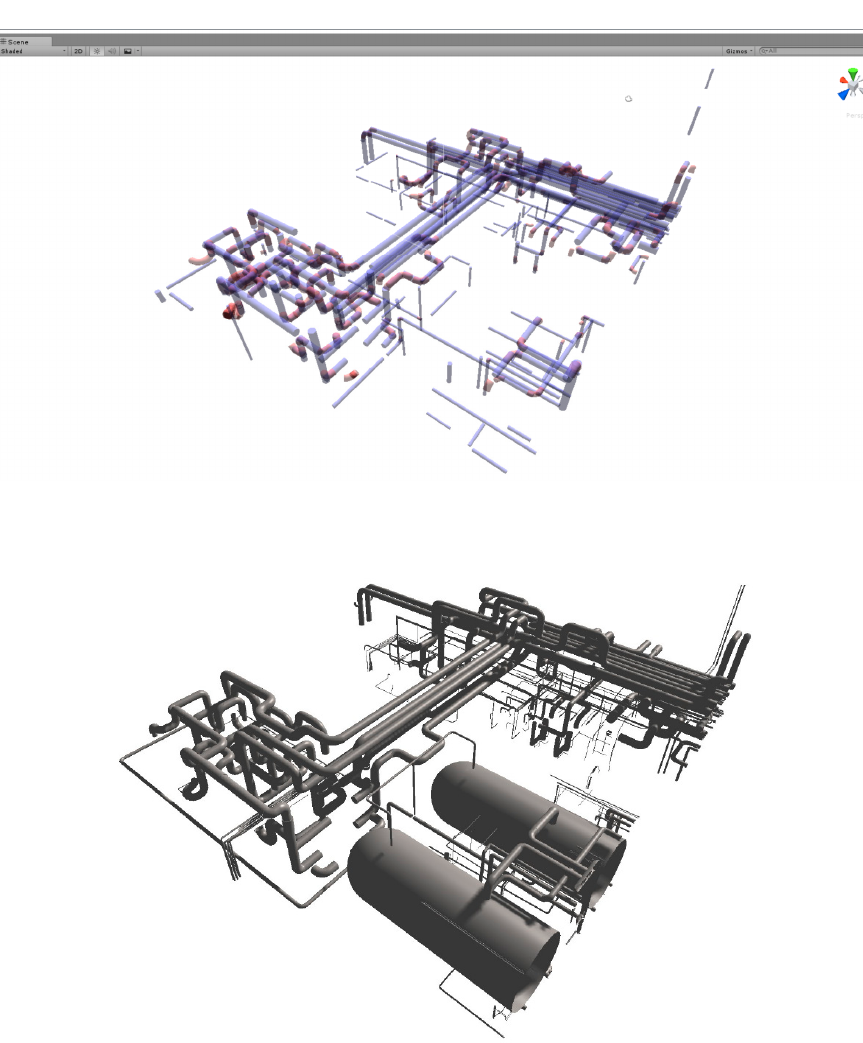
Figure A1. This figure is the result of modeling the point cloud data of Figure 12b by a human. The proposed method resulted in about 1 minute of execution time.